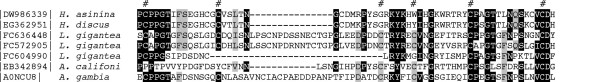
Sequence of ML5H8, a novel putative chitin-binding protein. An alignment of the ML5H8 protein with the sequences of chitin-binding domains of peritrophin-A type from molluscs and arthropods. Positions with < 80% and < 60% conservation are indicated in black and gray, respectively. Peritrophin-A is an extracellular domain that contains six conserved cysteines (indicated by #) that probably form three disulphide bridges. GenBank or Swiss-Prot numbers are indicated on the left.